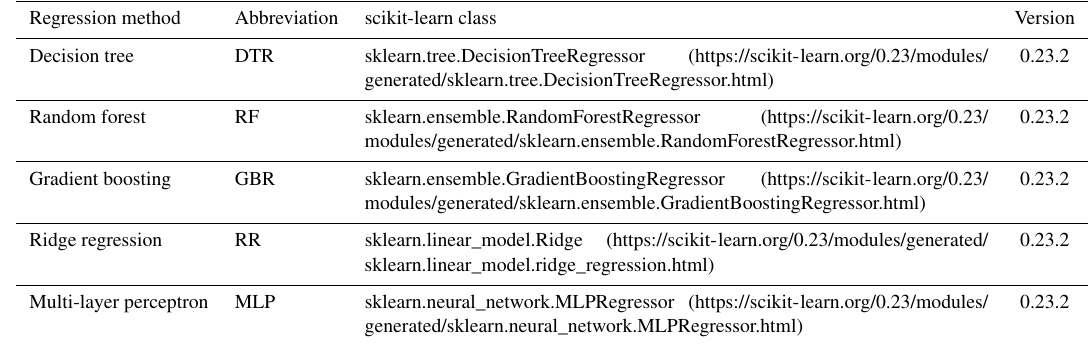
Table 1. Regression methods used and associated scikit-learn